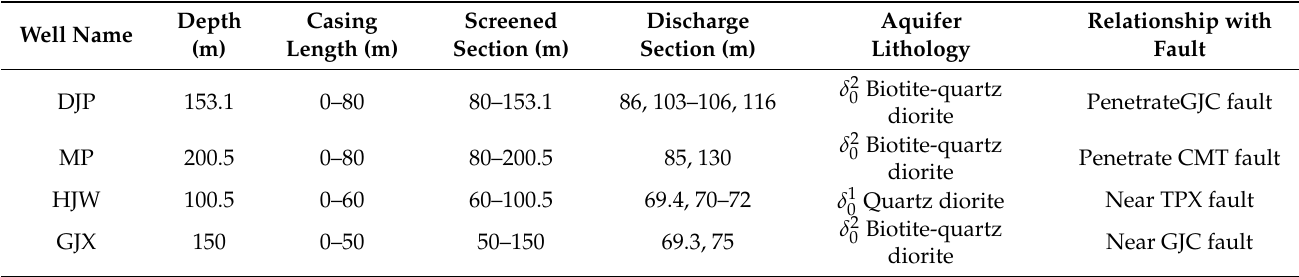
Table 2. Water chemistry and isotope measurement results in the studied four wells.